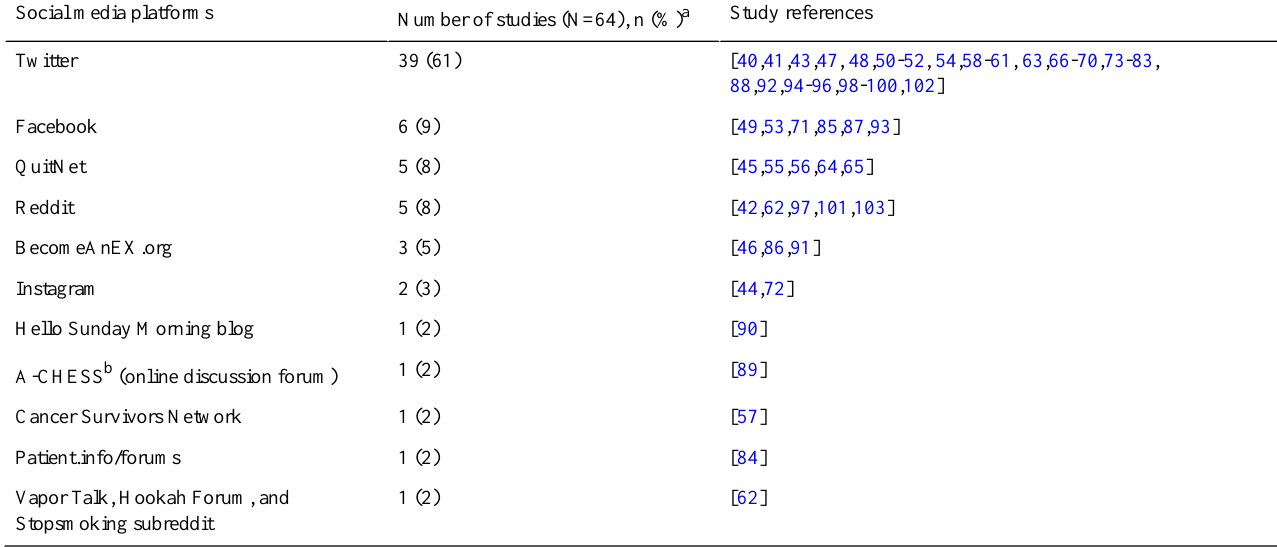
Table 1. Social media platforms used by various